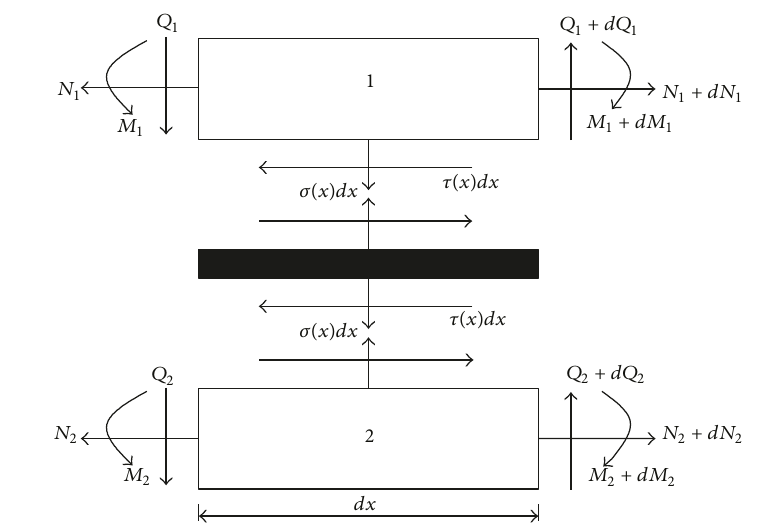
Figure 2: Infinitesimal isolated body diagram of